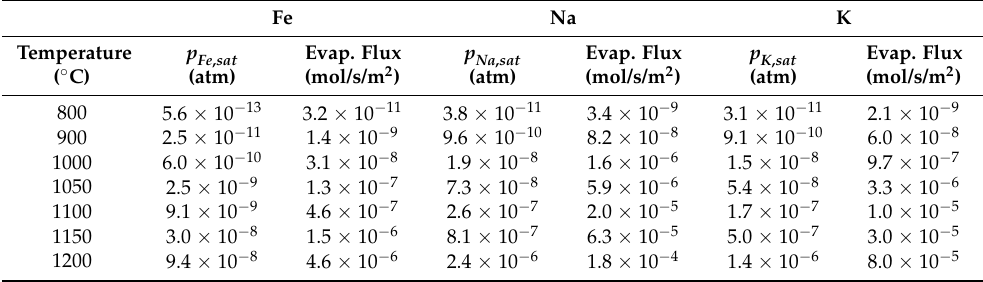
Figure 4. Comparison between measured saturated vapor pressure of species Fe, Na, and K from De Maria et al. [15] shown in blue, FactSage prediction assuming a pure oxide feed in green, and the closest oxide solution (FactSage) in yellow. The oxide systems represented by the yellow trend are Al 2 O 3 -CaO-Na 2 O, and Al 2 O 3 -K 2 O for Na and K, respectively. The predicted saturated vapor pressure of the species Fe, Na, and K between the temperatures of 800 ◦ C and 1200 ◦ C are shown in Table 2. Table 2 also shows the calculated evaporation flux in mol/s/m 2 determined using the HKL equation given the predicted saturated pressures for each species. As described above, the saturated vapor pressure for Fe was predicted from an FeO system, Na from an Al 2 O 3 -CaO-Na 2 O system, and K from an Al 2 O 3 -K 2 O system. Table 2. Predicted vapor pressures (FactSage), and calculated evaporation flux (HKL equation) of the elements Fe, Na, and K from an Apollo sample #12022